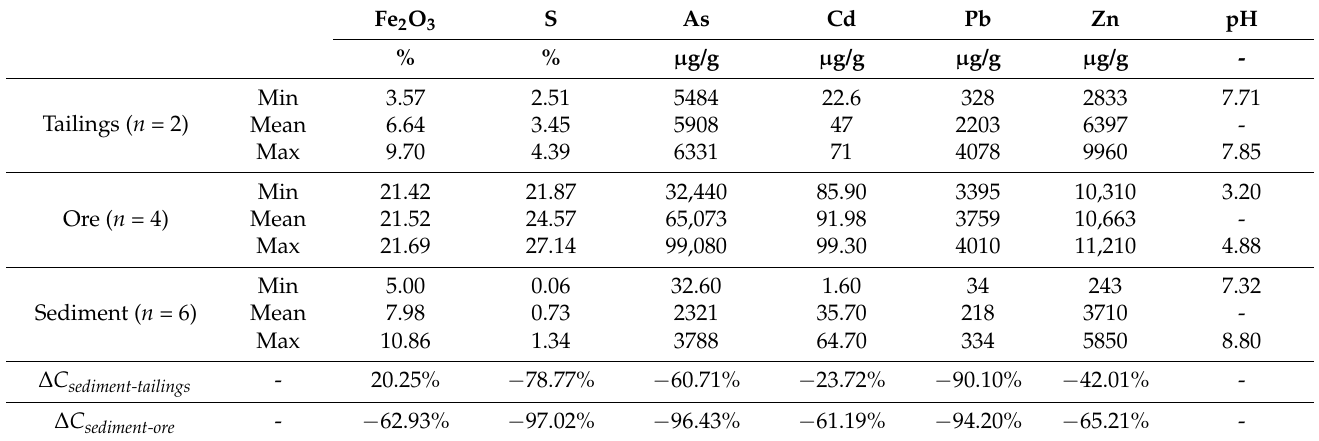
Table 3. Statistics of heavy metals characteristics of solid